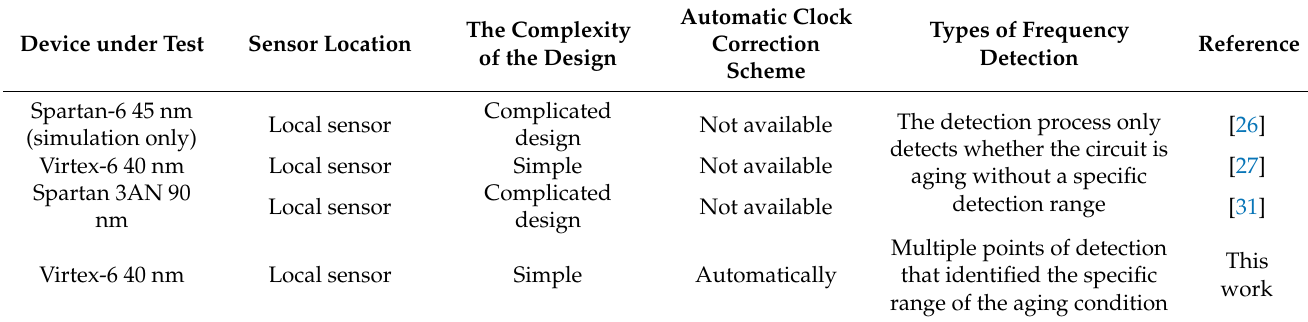
Table 6. Comparison of aging sensor design with automated clock correction